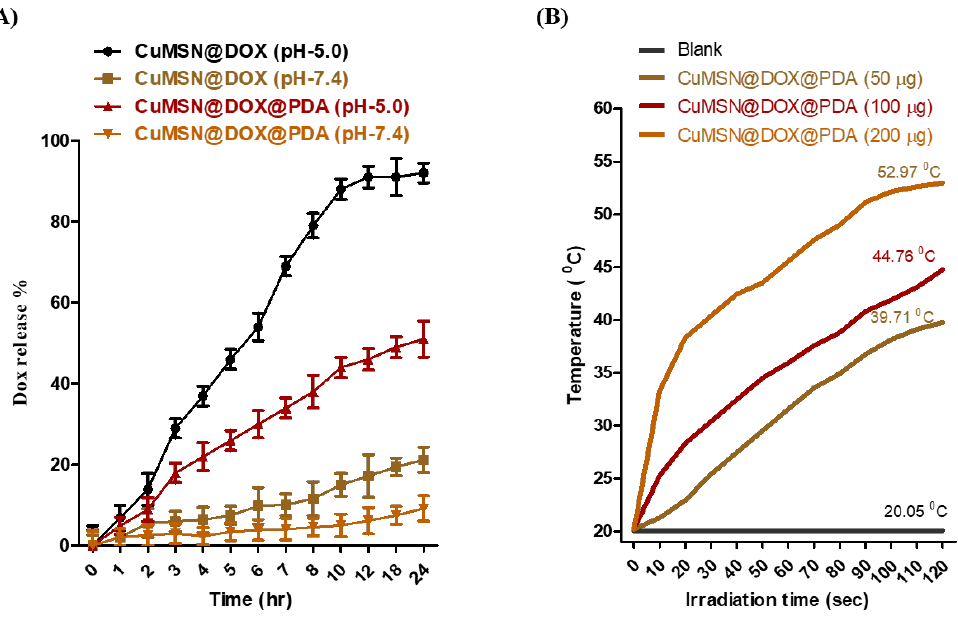
Figure 4. ( A ) DOX releasing from CuMSN@DOX and CuMSN@DOX@PDA over time at various PBS solutions of pH 5.0 and 7.4 (at 37 °C). ( B ) Temperature increasing profiles of CuMSN@DOX@PDA under 808 nm laser irradiation over time (50, 100, and 200 µg/mL).